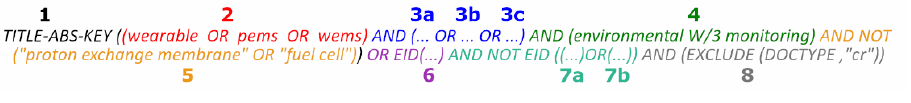
Figure 2. Query structure consisting of eight main sections.